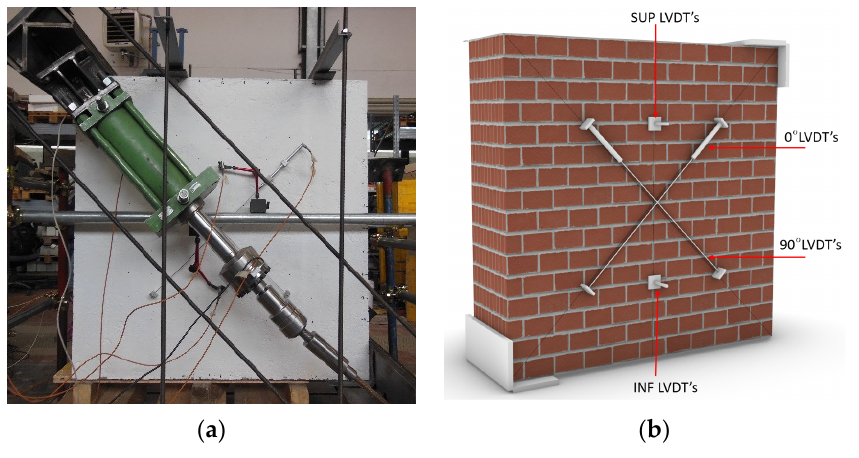
Figure 2. ( a ) Test set-up; ( b ) LVDT layout.